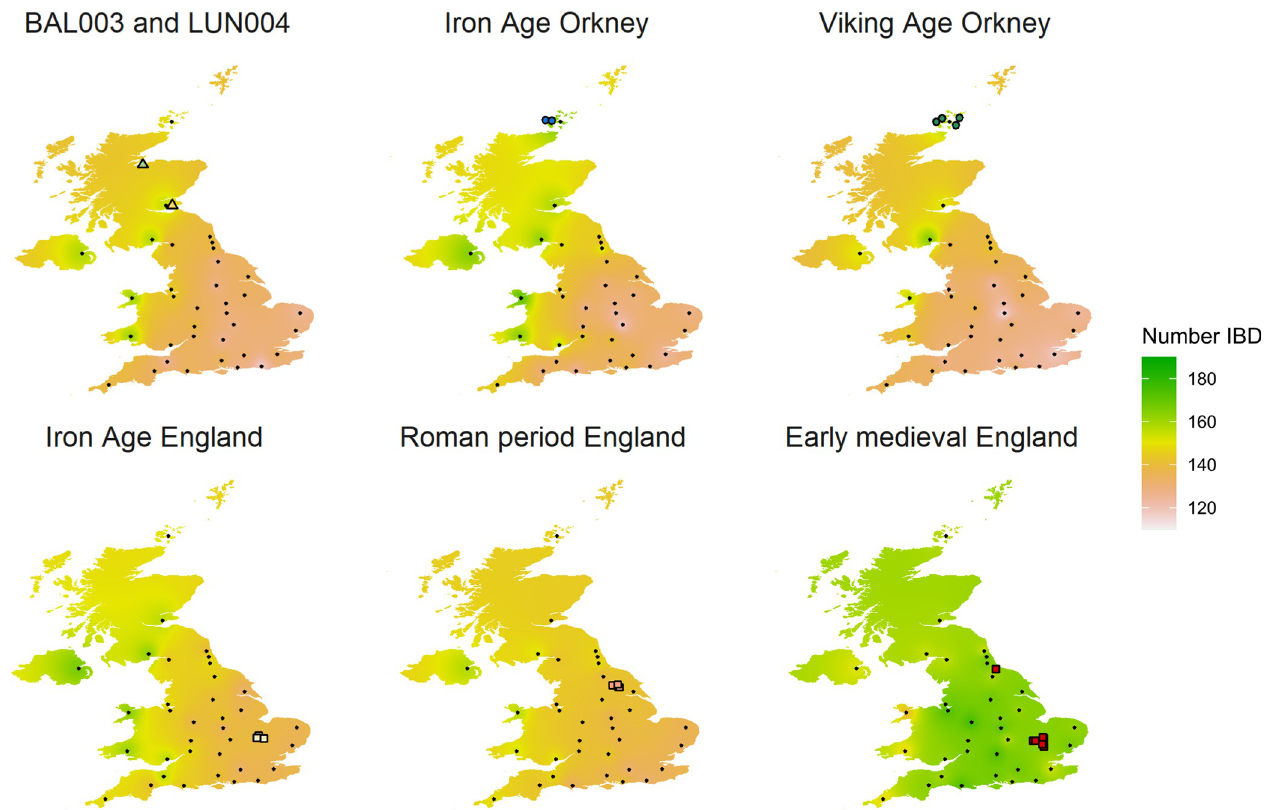
Fig 4. Average IBD sharing > 1 cM between present-day and ancient groups from the UK. IBD sharing between each of the ancient genomes and modern samples is illustrated in S22 Fig. Ancient individuals are indicated with coloured symbols. The black dots represent the geographic location of present-day people from 35 regions of the UK [11, 53], by the county